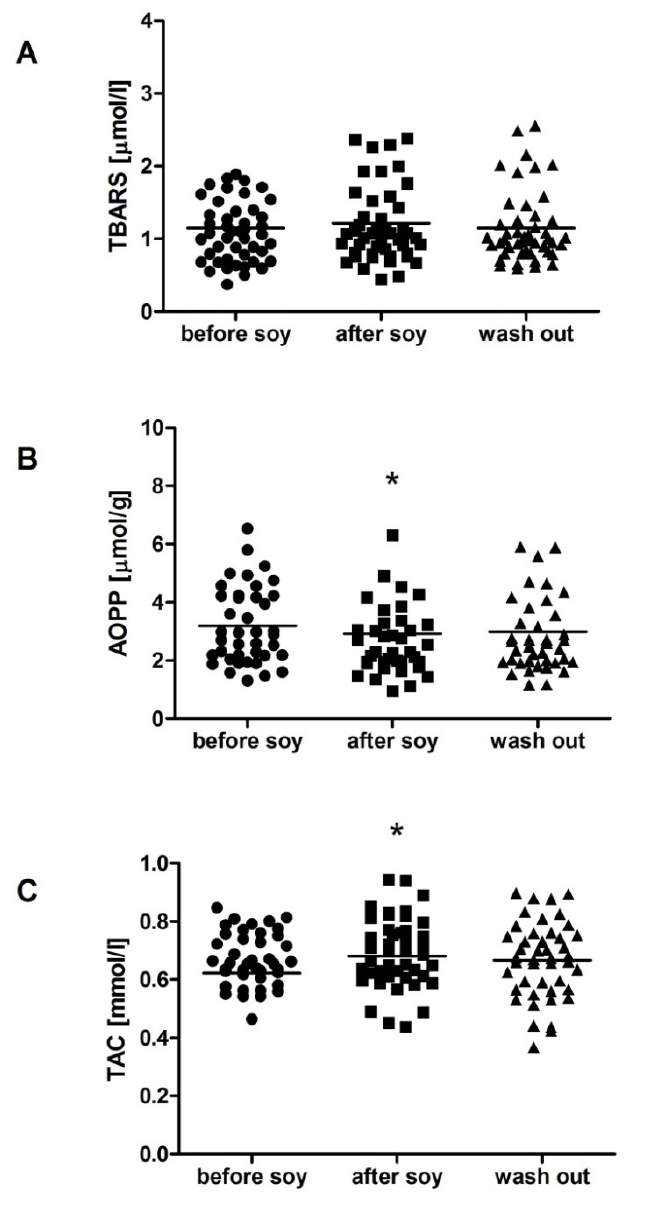
Figure 1. Oxidative stress parameters in women. Soy intake did not affect thiobarbituric acid reactive substances (TBARS) levels ( A ), but reduced advanced oxidation protein products (AOPP), while the effect persisted one week after soybean intake ( B ). Total antioxidant capacity of plasma (TAC) was increased after one week of soybean intake ( C ). * denotes p < 0.05 vs. before